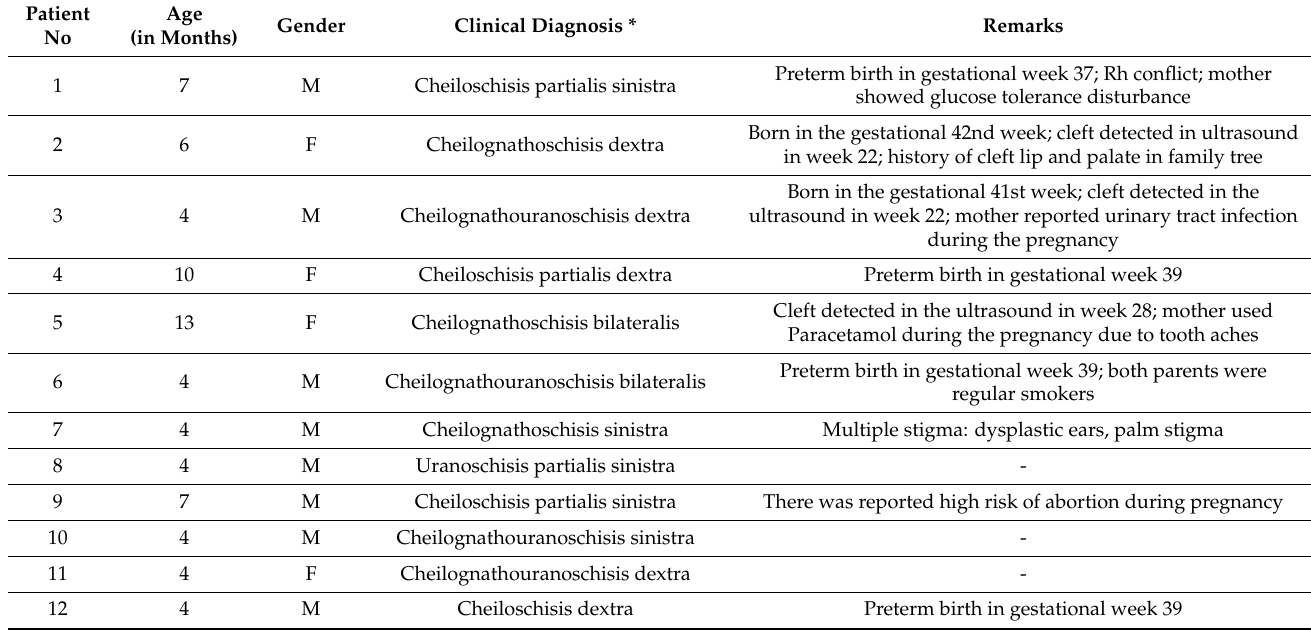
Table 1. Profile of study participants and clinical